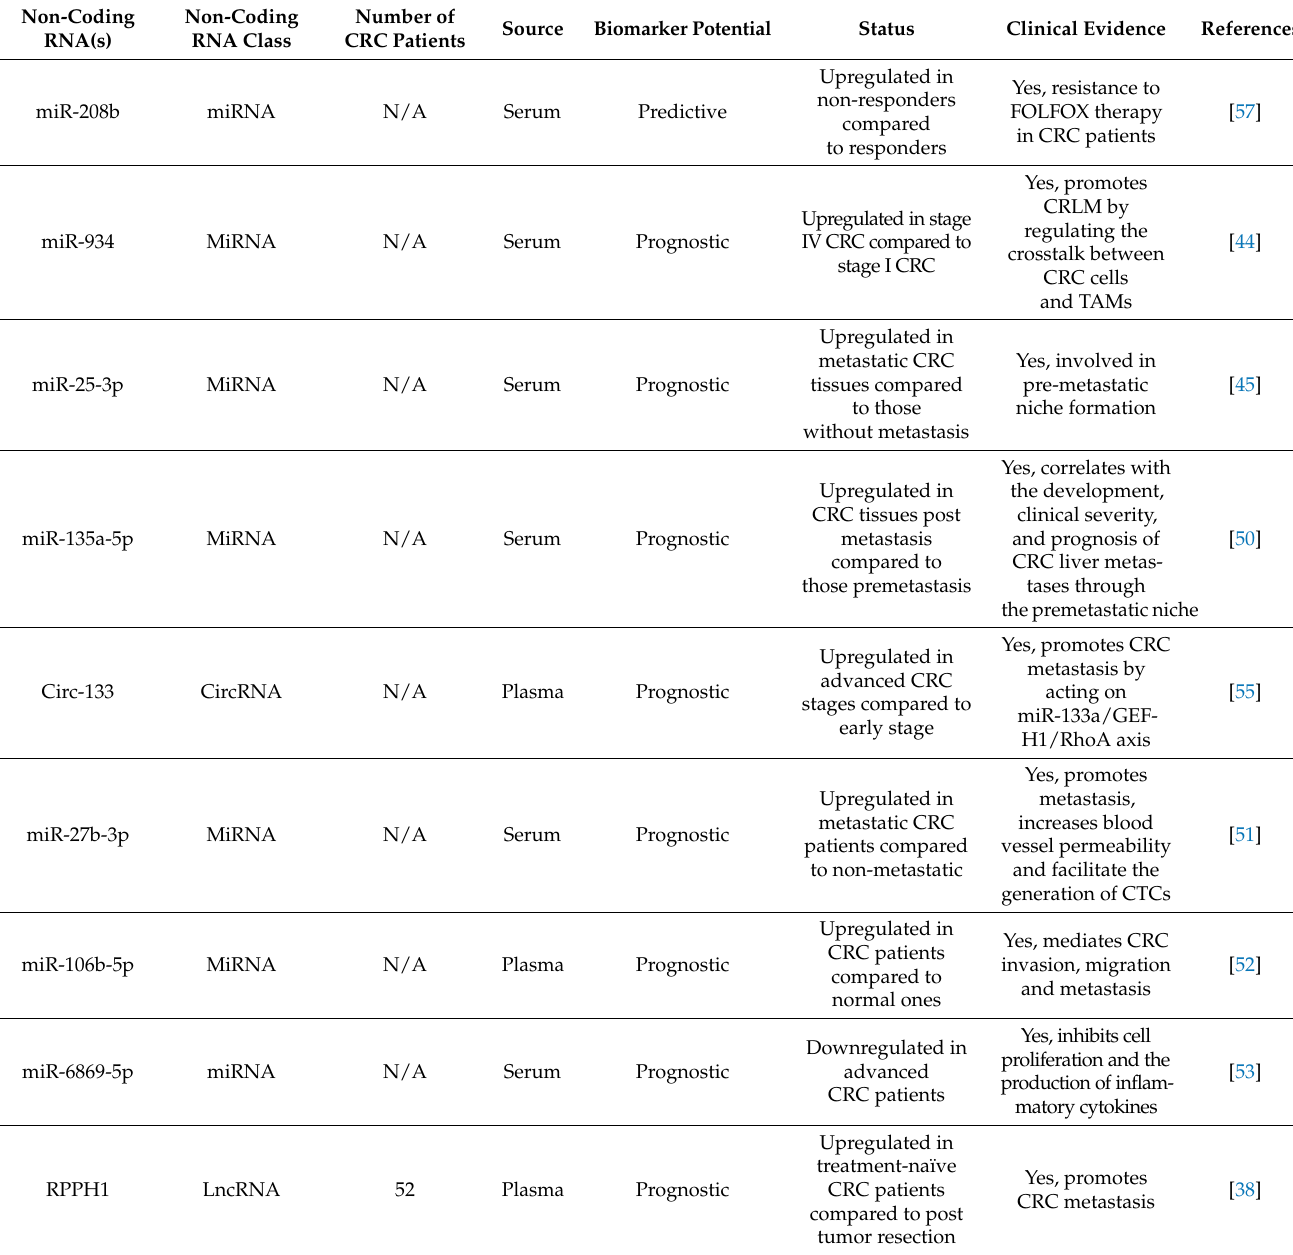
Table 2. Prognostic/predictive biomarker potential of exosomal ncRNAs in